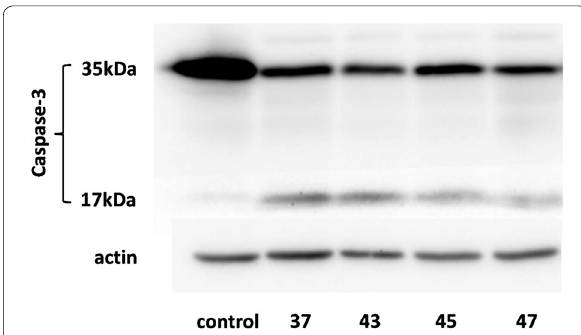
Fig. 1 Apoptosis of HL‑60 cells following rhodanine treatment. Cells incubated with the indicated compounds (50 μM) or the corre‑ sponding concentration of vehicle (control) for 48 h were lysed, and caspase‑3 cleavage was monitored by Western analysis of cell lysates (one representative experiment out of two similar ones is depicted)